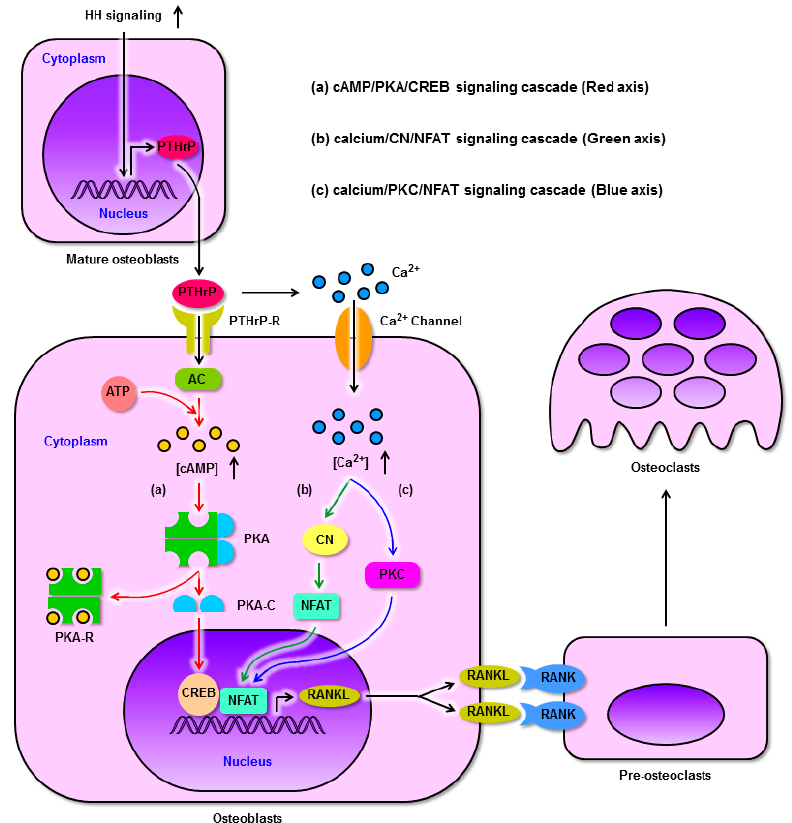
Figure 3. HH signaling regulates RANKL expression through PTHrP in osteoblasts and promotes osteoclast differentiation. ( a ): Enhanced HH signaling up-regulates the expression of PTHrP in mature osteoblasts, after which PTHrP binds its receptor on the osteoblast surface and activates AC. Activated AC converts ATP to cAMP. cAMP accumulates within cells and binds PKA-R, freeing the PKA-C subunits which undergo nuclear translocation and phosphorylate CREB. Subsequently, phosphorylated CREB binds to the RANKL promoter. ( b ) and ( c ): Meanwhile, PTHrP elevates intracellular calcium concentrations to activate both CN and PKC, in turn promoting the binding of NFAT to the RANKL promoter. As a result, CREB and NFAT cooperatively induce RANKL expression. Finally, RANKL binds RANK on the pre-osteoclast surface, driving osteoclastogenesis. AC, adenylate cyclase; cAMP, cyclic AMP; CN, calcineurin; CREB, cAMP responsive element binding protein; NFAT, nuclear factor of activated T cells; PKA, protein kinase A; PKA-C, PKA catalytic (C) subunit; PKA-R, PKA regulatory (R) subunit; PKC, protein kinase C; PTHrP, parathyroid hormone related protein; PTHrP-R, PTHrP receptor; RANK, receptor activator of nuclear factor- κ B; RANKL, RANK ligand.